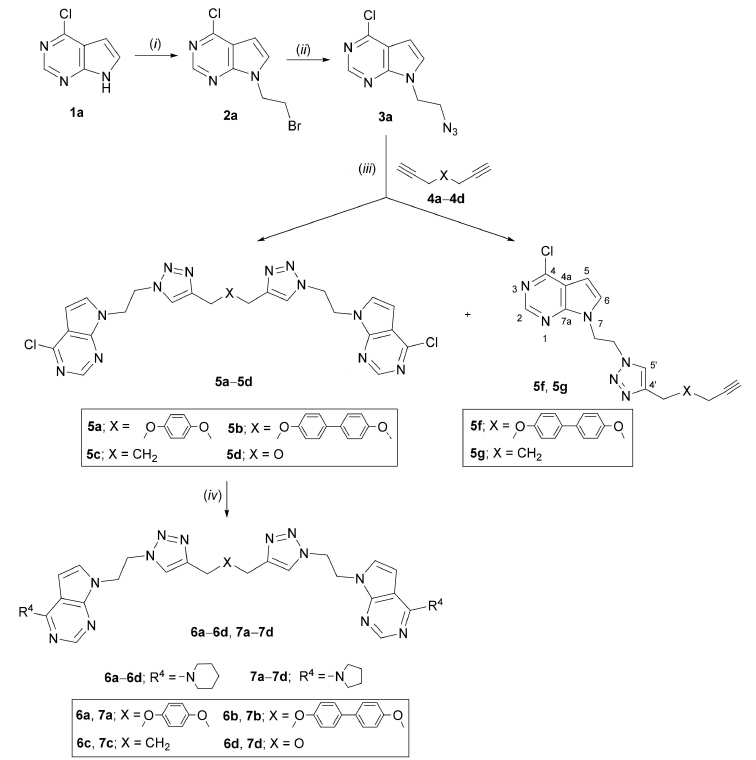
Scheme 1. Reagents and conditions : ( i ) BrCH 2 CH 2 Br, K 2 CO 3 , DMF, rt, 24 h; ( ii ) NaN 3 , acetone, reflux, 24 h; ( iii ) Method A: 1M CuSO 4 , Cu(0), t -BuOH:H 2 O = 1:1, DMF, rt, 120 h; Method B: 1M CuSO4, Cu(0), t -BuOH:H 2 O = 1:1, DMF, 50 ◦ C, US, 45 min, 1000 W; Method C: CuI, DIPEA, AcOH, CH 2 Cl 2 , rt., 72 h; ( iv ) piperidine/pyrrolidine, H 2 O, MW, 400 W, 100 ◦ C, 10 min.